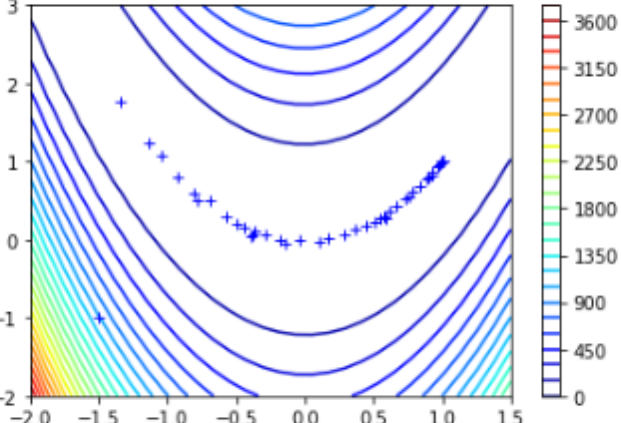
Figure 6. Global minima of the Rosenbrock function using q -BFGS algorithm [34]. For the starting point x 0 = ( − 1.5, − 1 ) , the Rosenbrock function converges to x ∗ = [ 1.0000000, 1.00000001 ] T , with f ( x ∗ ) = 1.541354346404984 e − 16 and ∇ q f ( x ∗ ) = [ 4.42018890 e − 07 , − 2.47425057 e − 07 ] T .